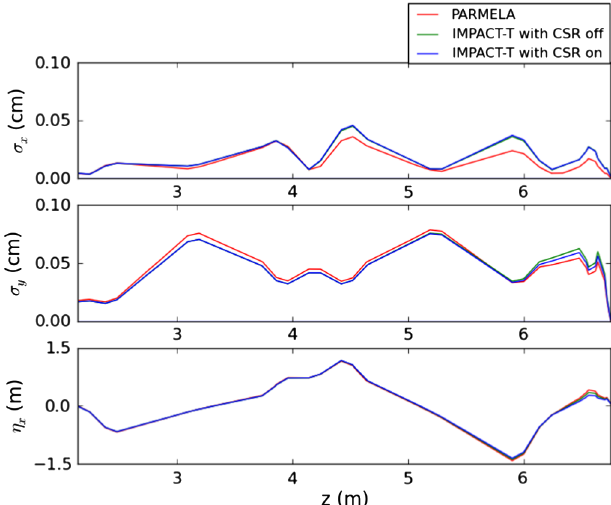
on.FIG. 10. The evolution of the redefined beta functions and the redefined dispersion function along the dispersive section of the second linac bunch compressor [i.e., Fig. 1(b)]. The red, green, and blue curves correspond to the simulation results by PARMELA , IMPACT - T with CSR effects turned off, and IMPACT - T with CSR effects turned on,